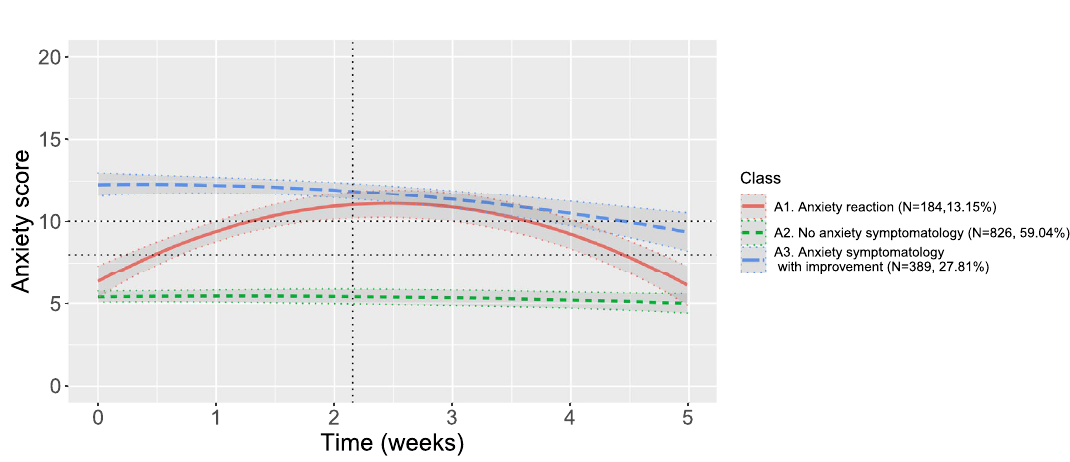
Figure 2. Predicted trajectories from the selected growth mixture model of anxiety. Dashed horizontal lines represent symptomatic thresholds for anxiety (i.e., 8 and 10). The dashed vertical line depicts the moment of Figure 2 gives the predicted trajectories from the selected model. Table 4 presents the fixed parameter esti- mates for each class. The A1 cluster, ‘anxiety reaction’ ( N = 184, 13.2%), represents people who started below the symptomatic threshold in anxiety, increased to symptomatic levels around unlockdown, and came back to their initial level two to three weeks later. Cluster A2, ‘no anxiety symptomatology’ ( N = 826, 59.0%), includes people who presented no anxiety problems from the beginning to the end of the assessments. Cluster A3, named ‘anxi- ety symptomatology with improvement’ ( N = 389, 27.8%), characterised people who started with high levels of anxiety—beyond the symptomatic threshold—and saw their anxiety slowly decrease, particularly after the end of lockdown. Multinomial logistic regressions. Predicting depression trajectories. Table 5 presents the odds ratios from the multinomial logistic models of depression trajectories for classes D1, D2 and D4 with the no depres-